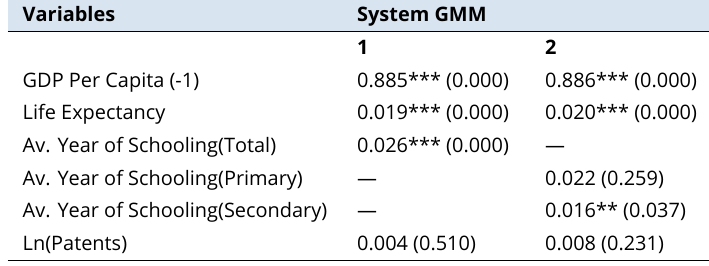
Low income: Patents, human capital and